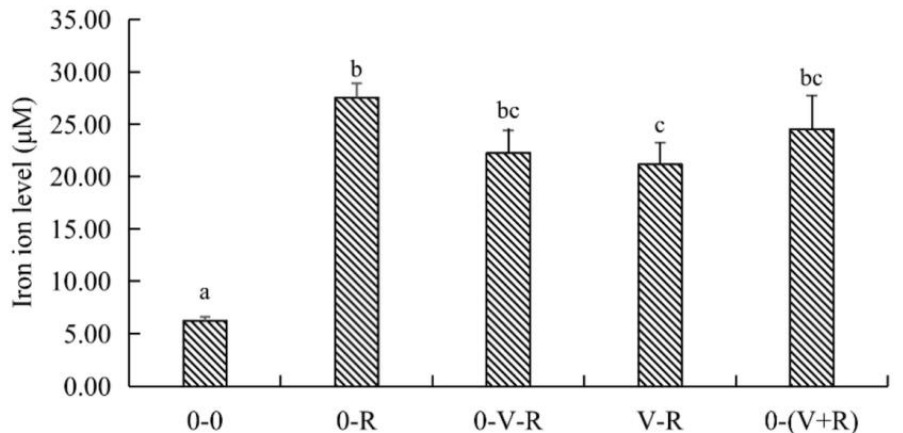
Figure 4. Effects of different incubation patterns of 1,25(OH) 2 D 3 on iron ion level of ZFL after being treated with 3 µ M RSL3 for 6 h ( n = 6). Error bars represent the standard error of each group, and means with different superscript letters (a, b, c) are significantly different ( p < 0.05),while the same letter means no statistical difference between two